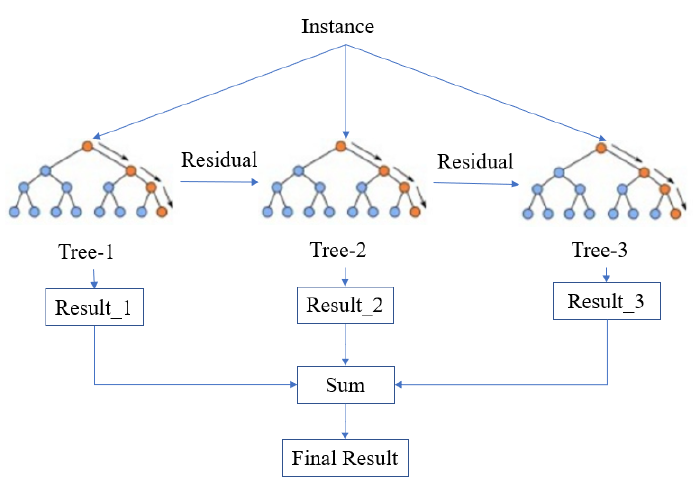
Figure 2. Simplified structure of